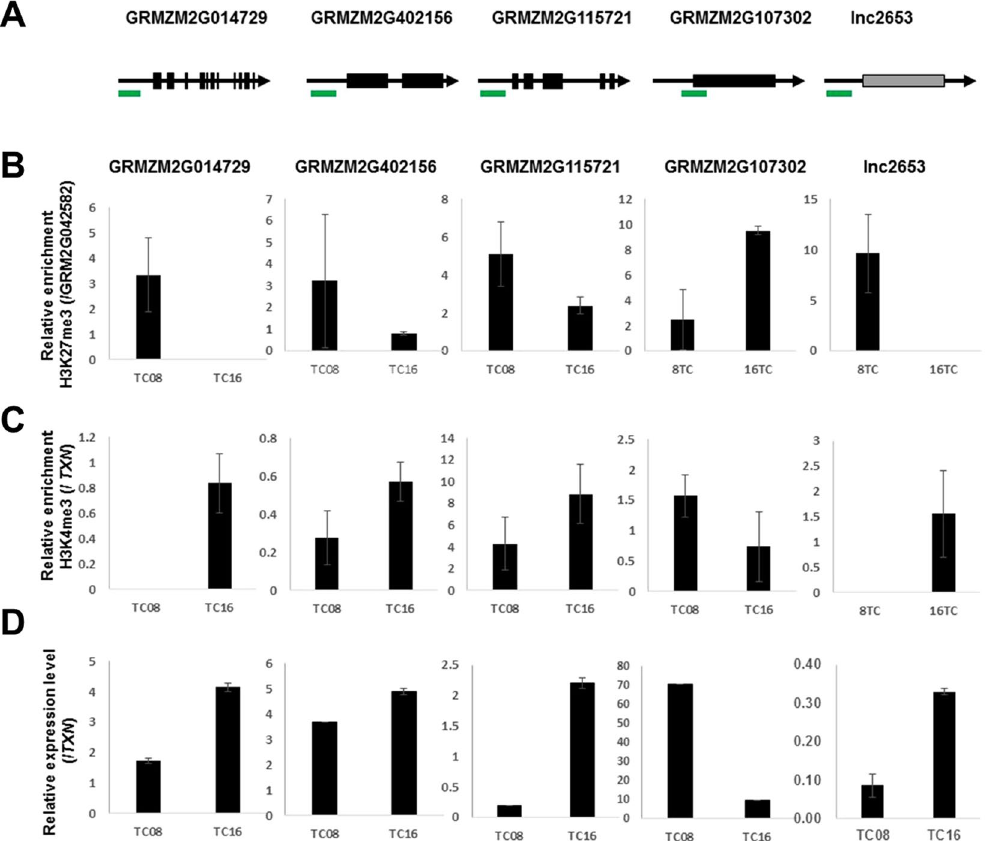
Figure 6. Correlation among RNA expression, H3K27me3, and H3K4me3 in BETL at 8 DAP (TC08) and 16 DAP (TC16). ( A ) Schematic representation of the locations of amplicons used for ChIP assays. ( B ) Spatio- temporal enrichment of H3K27me3 at indicated loci plotted relative to GRM2G042582. ( C ) Spatio-temporal enrichment of H3K4me3 at indicated loci plotted relative to TXN (GRMZM2G066612). ( D ) mRNA expression at indicate loci relative to expression of TXN